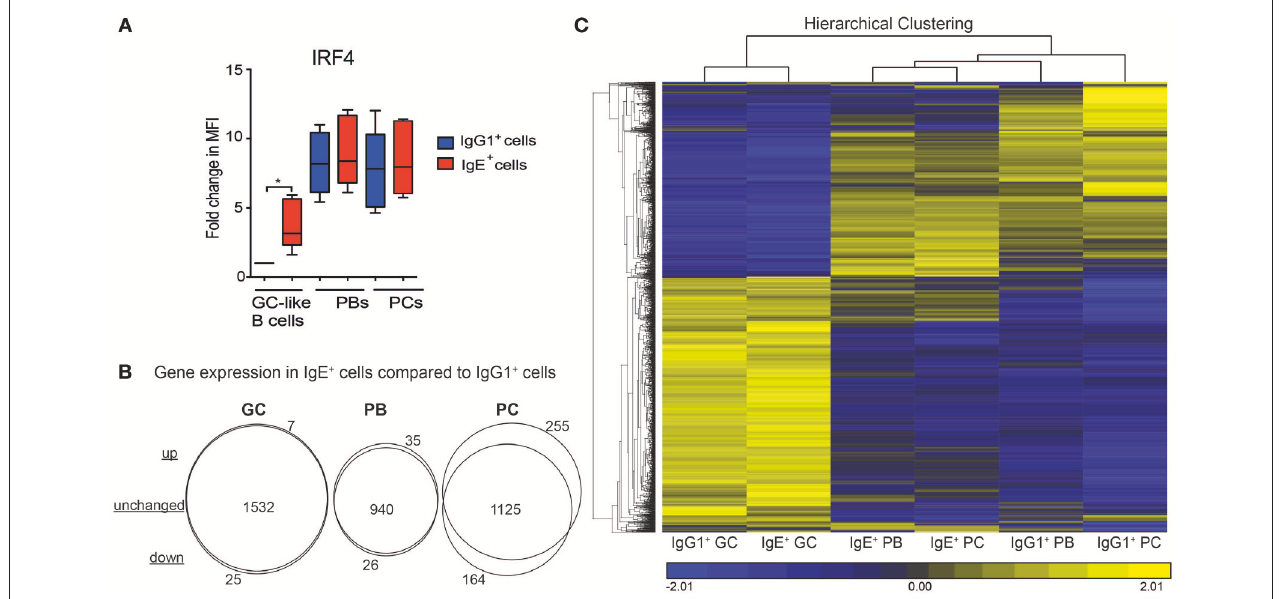
FIGURE 3 | The relationship between the IgE + and IgG1 + cells along their differentiation pathway. (A) Expression levels of IRF4 in IgE + and IgG1 + cells as determine by flow cytometry. Data show the fold change in median fluorescence intensity (MFI) of anti-IRF4 stained cells relative to IgG1 + GC-like B cells ( n = 6). Statistical analysis was performed using the One-Way ANOVA, Dunnett’s test (* P < 0.05). (B) Visualization of gene expression differences between IgE + and IgG1 + cells along their PC differentiation pathway. Genes differentially expressed ( > 1.5-fold, p < 0.05) at each IgE + and IgG1 + cell differentiation stage underwent a 2-way ANNOVA analysis. The number of genes that were significantly ( p < 0.05) up-regulated or down-regulated by > 1.5-fold in IgE + cells compared to IgG1 + cells at GC, PB, and PC are highlighted by the Venn diagrams. (C) , Unsupervised K-means hierarchical clustering of all genes differentially expressed in IgE + and IgG1 + cells along their differentiation pathway. Each column represents the mean gene expression profile from all four donors of the specified phenotypic